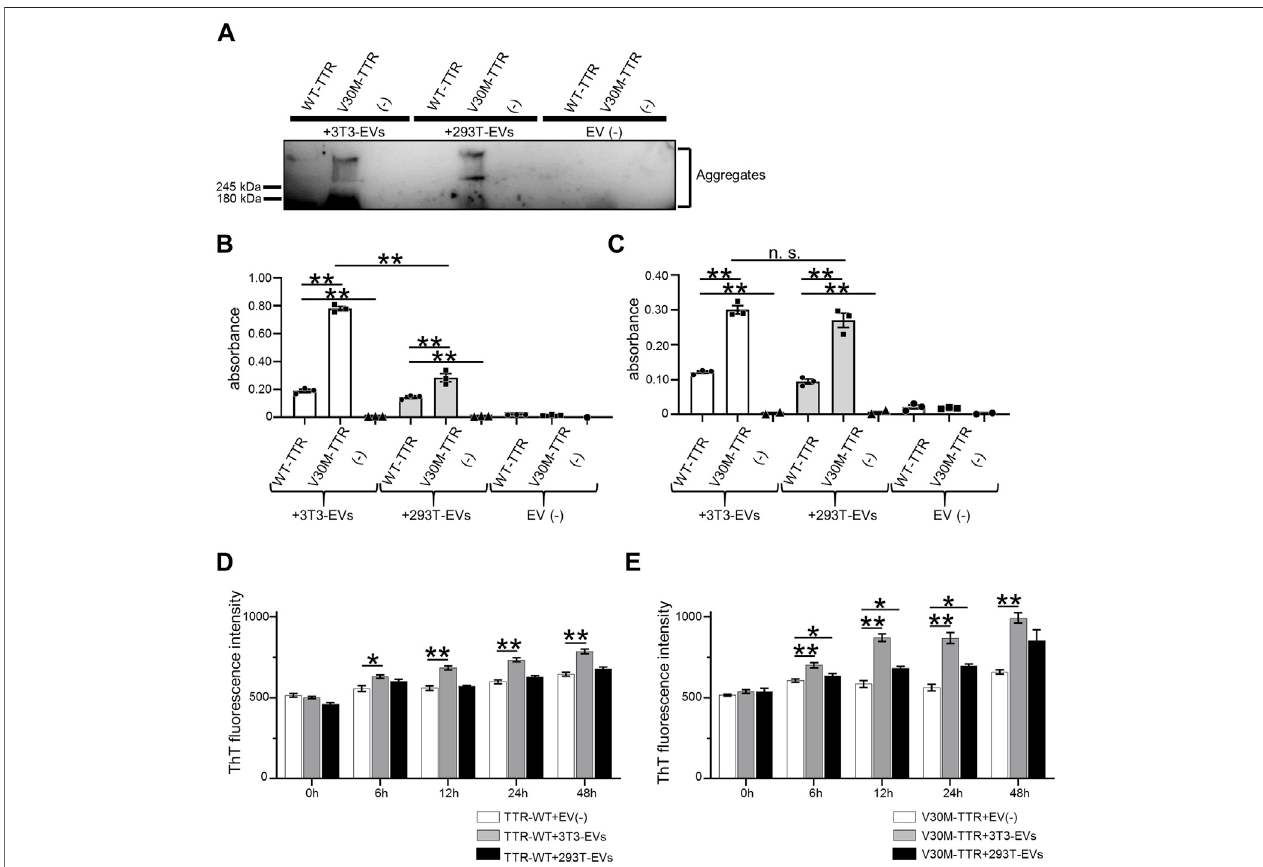
FIGURE 2 | EVs are easily combined with puri fi ed V30M-TTR. (A) Mixture of NIH3T3-derived EVs, HEK293T-derived EVs or non-EVs, and puri fi ed TTR in non- shakingconditionsfor48 hused forwesternblottinganalysis.Ladderbandssuggestive ofaggregateswerecon fi rmedabovethetopoftherunninggelonV30-TTRand both EVs. (B) Remaining samples were diluted and used for EV ELISA. Binding of cell line-derived EVs to TTR was indicated by the increased absorbance in EV ELISA. NIH3T3-derived EVs were more likely to bind to TTR than HEK293T-derived EVs. N = 3, mean ± S.E.; **, p < 0.005; n.s., not signi fi cant, ANOVA with Tukey ’ s post hoc test. (C) The same samples as the previous experiment were shaken at 500 rpm and used for EV ELISA. TTR-V30M with cell line-derived EVs showed higher absorbance than TTR-WT. N = 3, mean ± S.E.; **, p < 0.005; n.s., not signi fi cant, ANOVA with Tukey ’ s post hoc test. (D) Increase of Thio fl avin T (ThT) fl uorescence intensity (FI) in a mixture of EVs and puri fi ed WT-TTR with acidic buffer observed by ThT assay. FI value decreased in the following order: TTR with NIH3T3-derived EVs, HEK293T-derived EVs, and elution buffer in both WT-TTR and V30M-TTR. N = 4, mean ± S.E.; *, p < 0.05; **, p < 0.005; ANOVA with Tukey ’ s post hoc test. (E) Same experiment with V30M-TTR. FI value decreased in the same order as for WT-TTR. FI value of V30M-TTR was generally higher than that of WT-TTR. N = 4, mean ± S.E.; *, p < 0.05; **, p < 0.005; ANOVA with Tukey ’ s post hoc